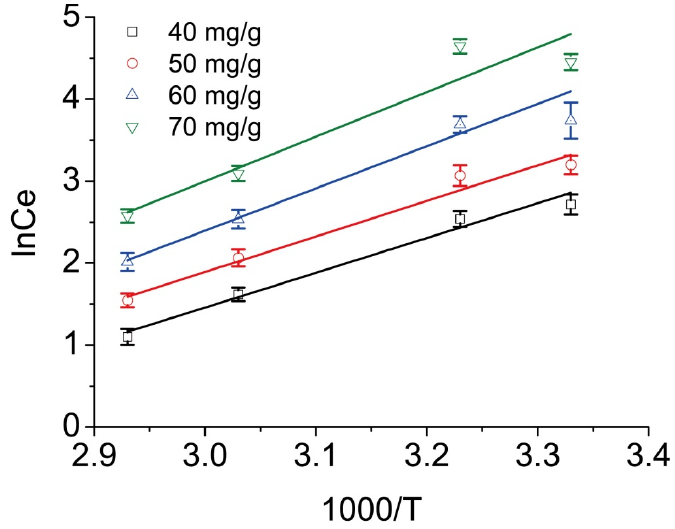
Figure 5. Determination of enthalpy of methyl orange adsorption onto the MRCM (The different colored lines represent the adsorption isograms when the isosorption amounts are 40, 50, 60 and 70 mg/g, respectively). Table 8. Thermodynamic properties of the methyl orange adsorption onto MRCM.